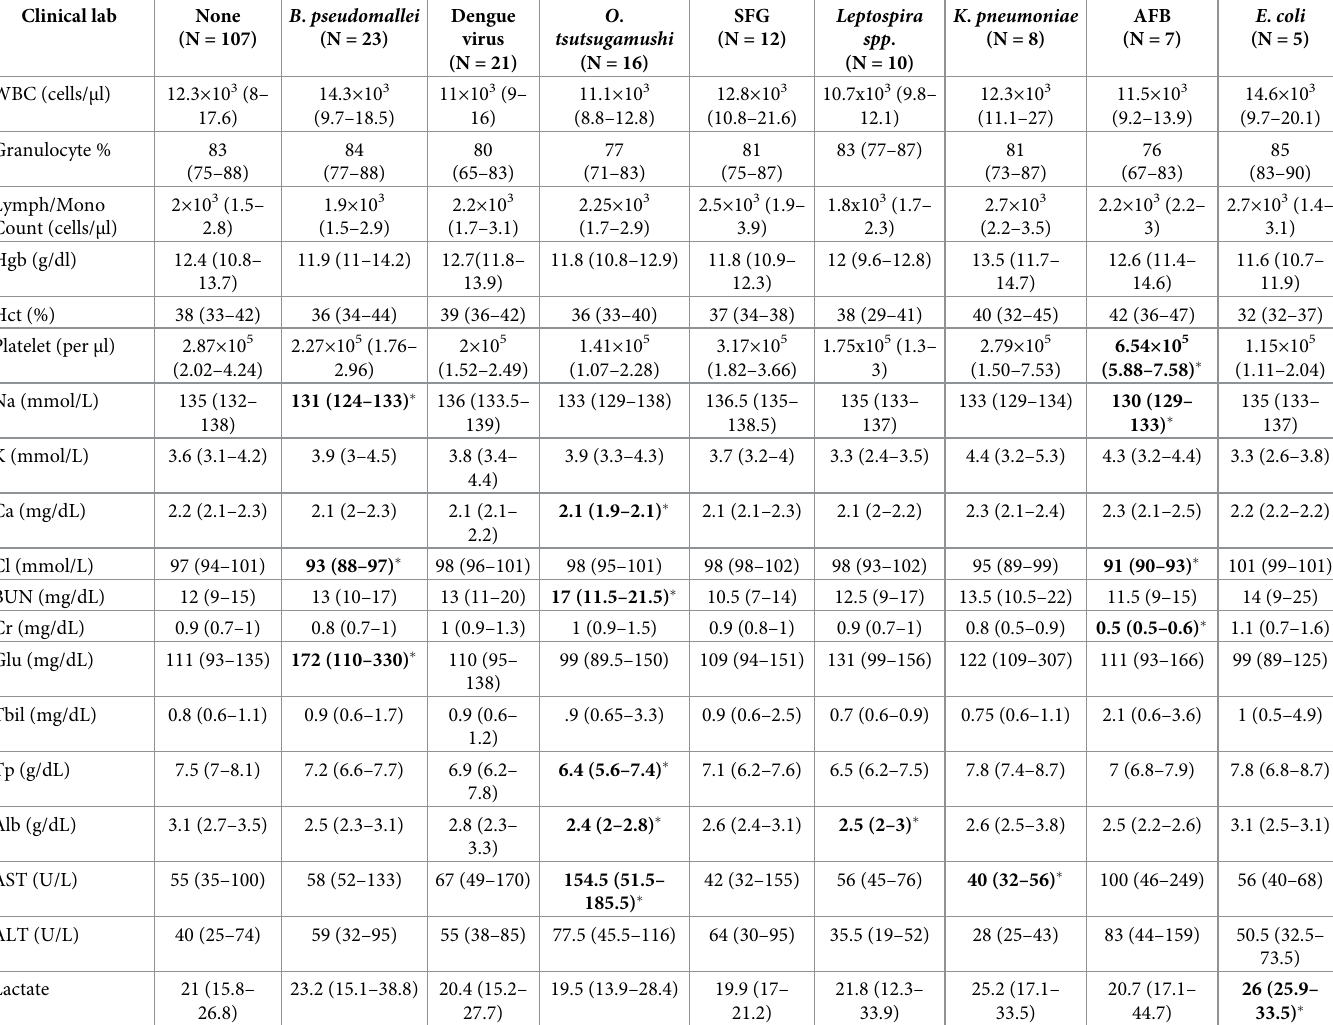
Table 5. Summary of clinical laboratory results associated with pathogen groups. Clinical laboratory values were compared for patients with different infectious etiolo- gies as described above. All tests of statistical significance were two-tailed, and significance was defined as p < 0.05. Values are medians (IQR). Bolded value with asterisk indicates the value is significantly different from patients without the indicated pathogen. Note: WBC, White Blood Count; Hgb, Hemoglobin; Hct, Hematocrit; Na, Sodium; K, Potassium; Ca, Total Calcium; Cl, Chloride; BUN, Blood Urea Nitrogen; Cr, Creatinine; Glu, Glucose; Tbil, Bilirubin; Tp, Total Protein; ALB, Albumin; AST, Aspartate aminotransferase; ALT, Alanine Aminotransferase. Clinical